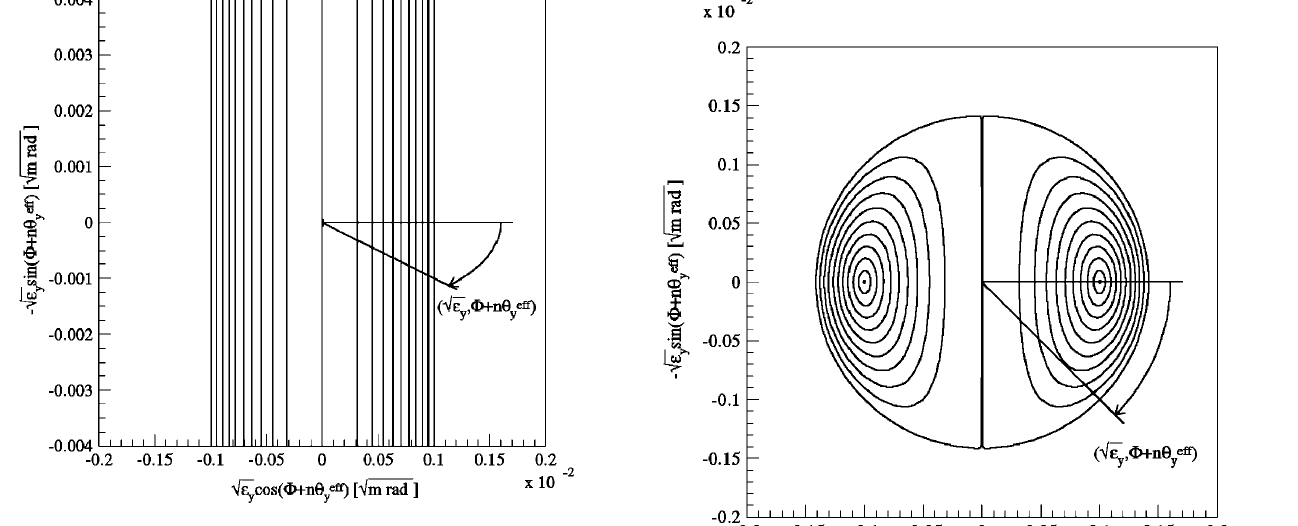
(cid:17) 1 (cid:11) y FIG. 5. Resonant invariant for the emittance-beating reso- nance controlled using SQM’s in the initial case where (cid:31) (cid:2) 2 (cid:11) 10 (cid:3) 6 m rad and Q (cid:31) y